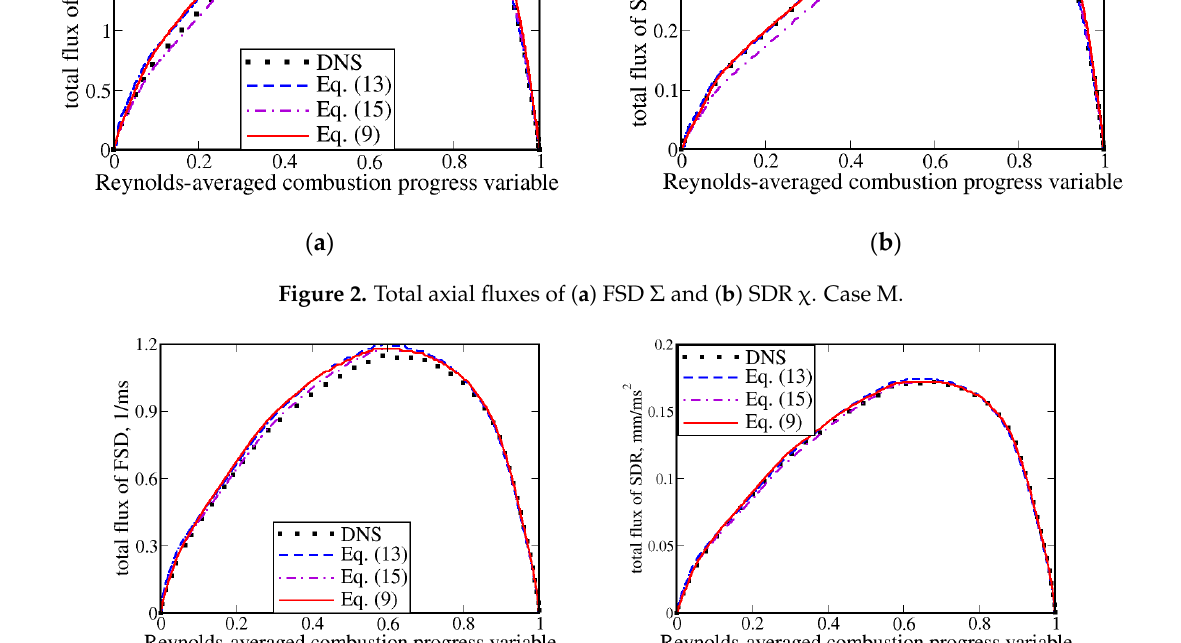
Figure 3. Total axial fluxes of ( a ) FSD Σ and ( b ) SDR χ . Case L.